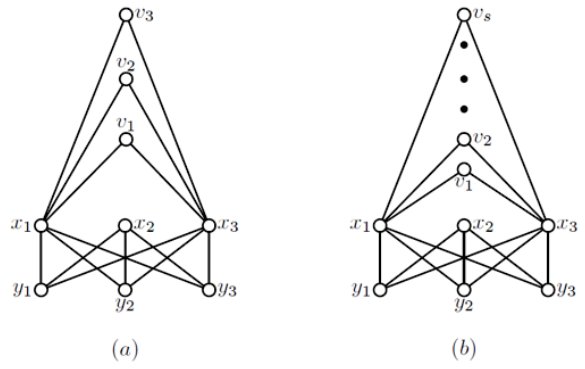
Figure 1: (a) the graph H 3,3